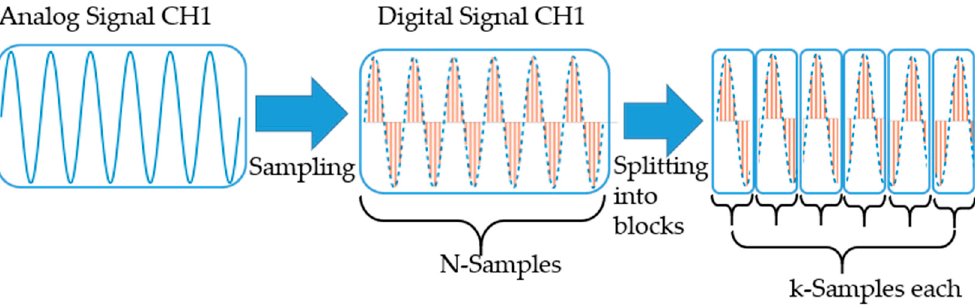
Figure 8. Visualization of the process of digitizing and splitting the individual channels into blocks (the shown signal is chosen only for visualization with a low frequency; in the real signal there are several hundred periods in each block).